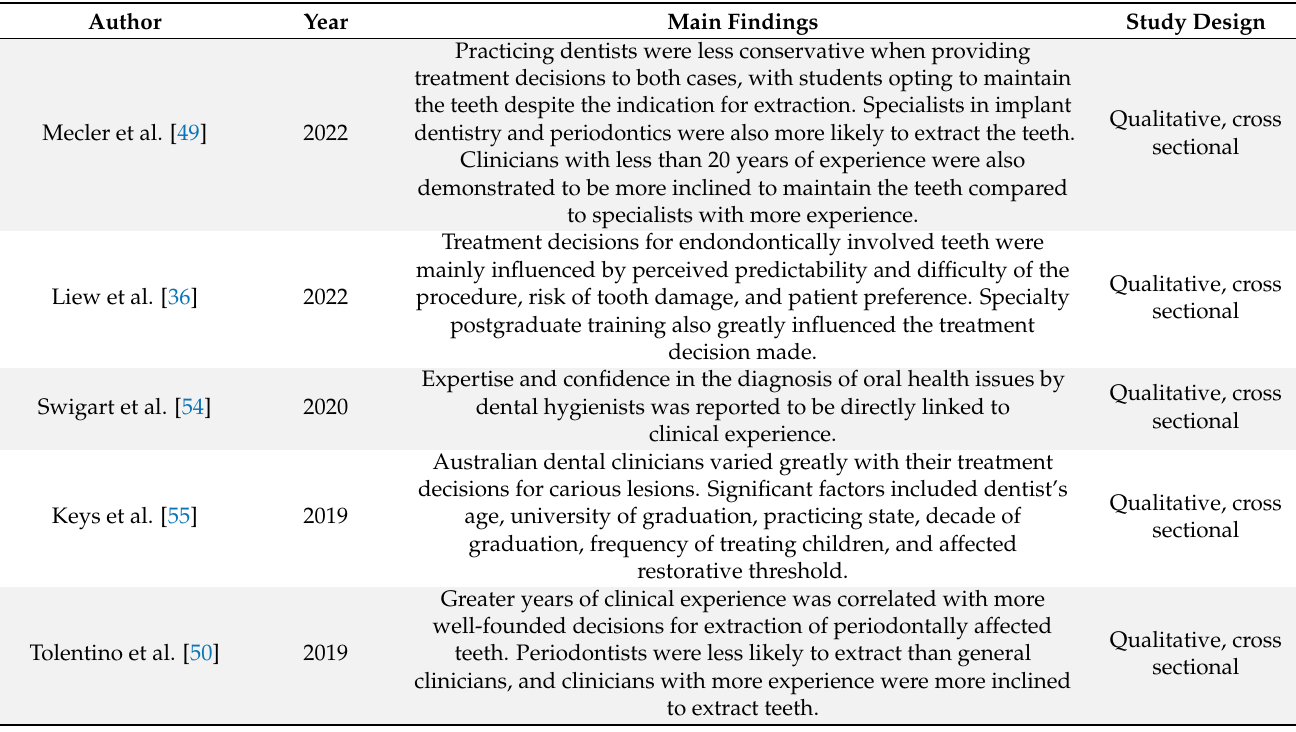
Table 3. Extracted articles that investigated clinical experience affecting confidence in decision making under